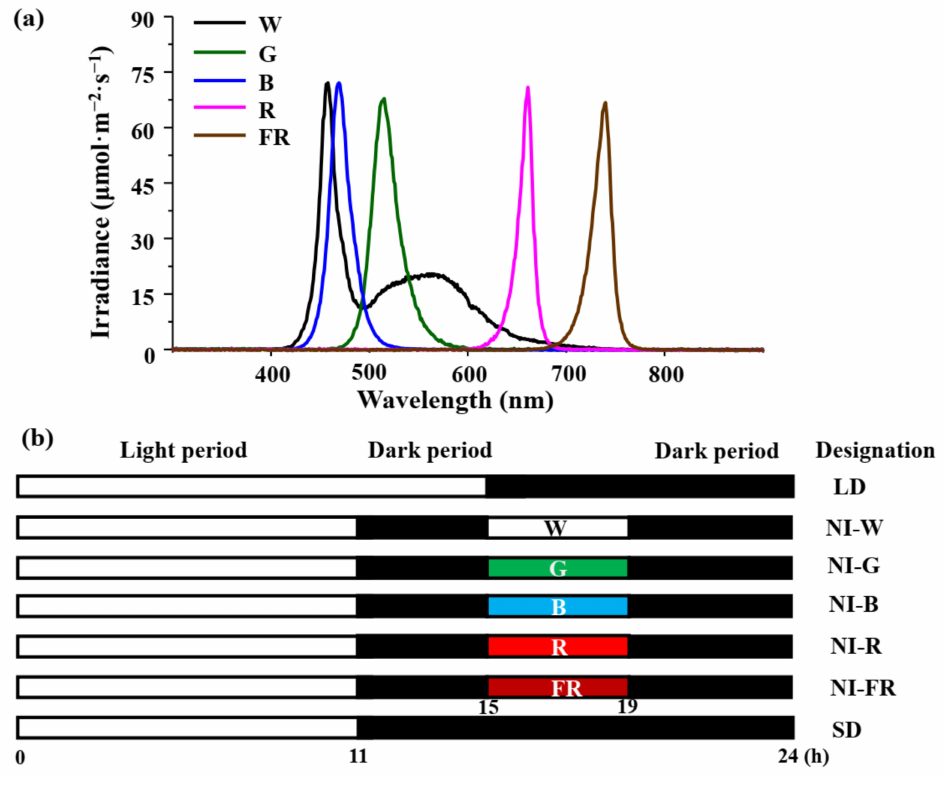
Figure 1. The light spectral distribution of the LEDs ( a ) and night interruption light ( b ) used in this study: W, white; G, green; B, blue; R, red; FR, far-red; LD, long day; NI, night interruption; and SD, short